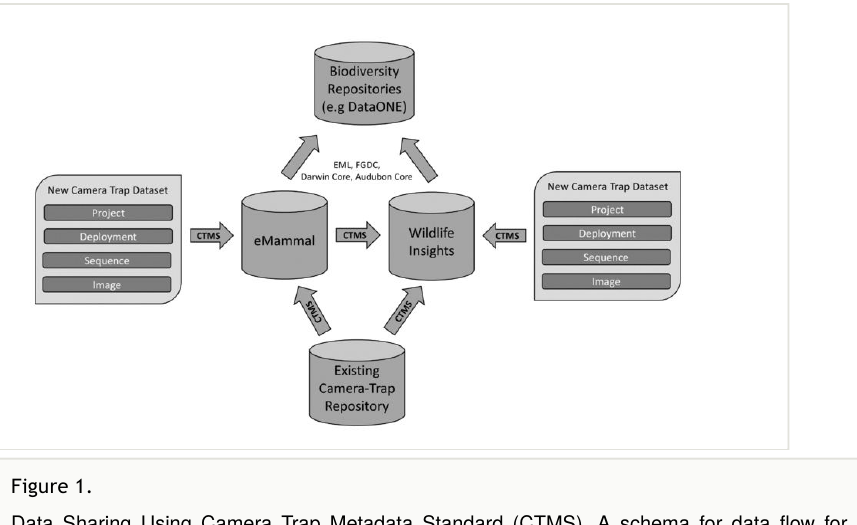
Data Sharing Using Camera Trap Metadata Standard (CTMS). A schema for data fl ow for researchers importing data into repositories and for data moving between